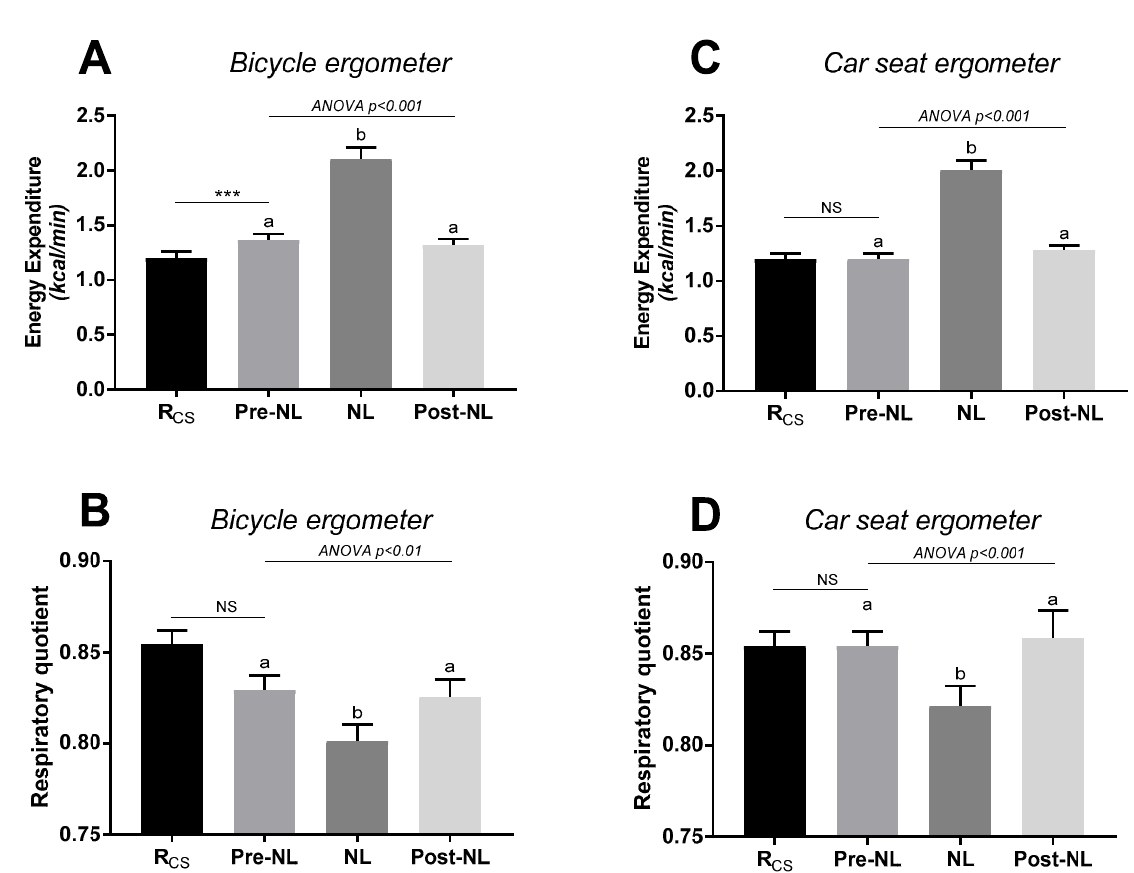
Figure 2. Energy expenditure (upper panels) and respiratory quotient (lower panels) at rest and in response to no-load (NL) cycling using the bicycle ergometer (panels A , B ) or the car seat ergometer (panels C , D ). Rcs = at rest while sitting in car seat ergometer; NL= no-load cycling: sitting (car seat or bicycle) and cycling at 60 rpm at no-load; pre-NL and post-NL: at rest while sitting in car seat or bicycle with feet on pedals before and after no-load cycling, respectively. Values are mean ± SEM. An ANOVA test was applied across pre-no-load, no-load, and post-no-load, followed by post hoc pairwise comparisons using Tukey’s test; values with different superscripts (a, b) are significantly different from each other ( p < 0.05). A paired t -test was applied for comparing Pre-NL vs Rcs; ***: significant difference at p < 0.001.